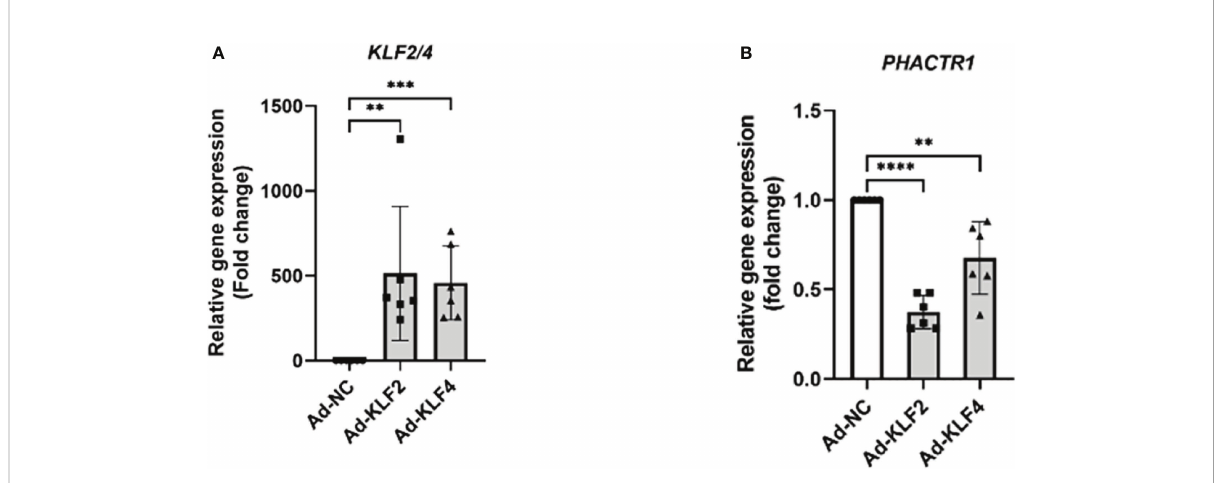
FIGURE 5 KLF2 and KLF4 suppress PHACTR1 gene expression. (A) Validation of KLF2 and KLF4 gene overexpression by adenovirus (n = 6). (B) PHACTR1 gene expression was suppressed by Ad-KLF2 and Ad-KLF4 after 24 h of transfection (n = 6). **P < 0.01, ***P < 0.001, ****P <